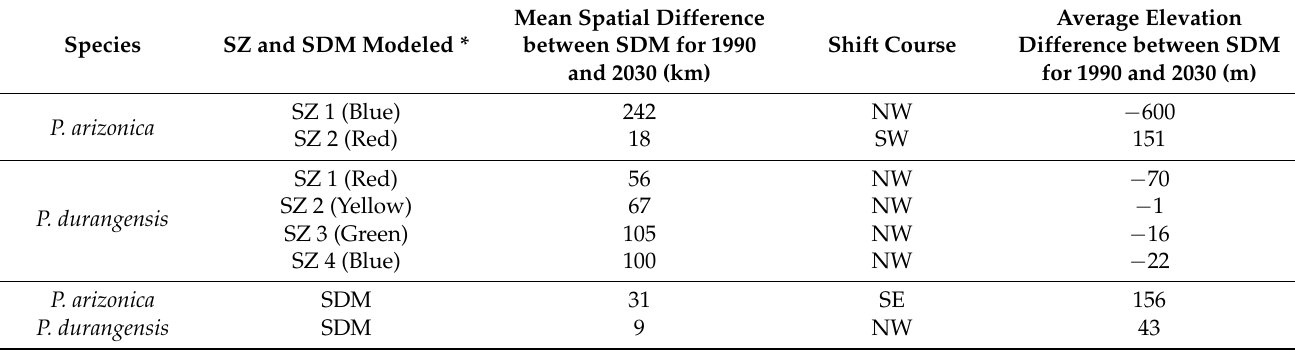
Table 3. Changes in location and elevation of the of seed zones (SZ) per species, according to the species distribution models (SDM), from the period 1960–1990 to the period 1990–2030 (RCP ~ 4.5 Wm-2), for Pinus arizonica and P. durangensis ; see Figures 4 and 5 for color